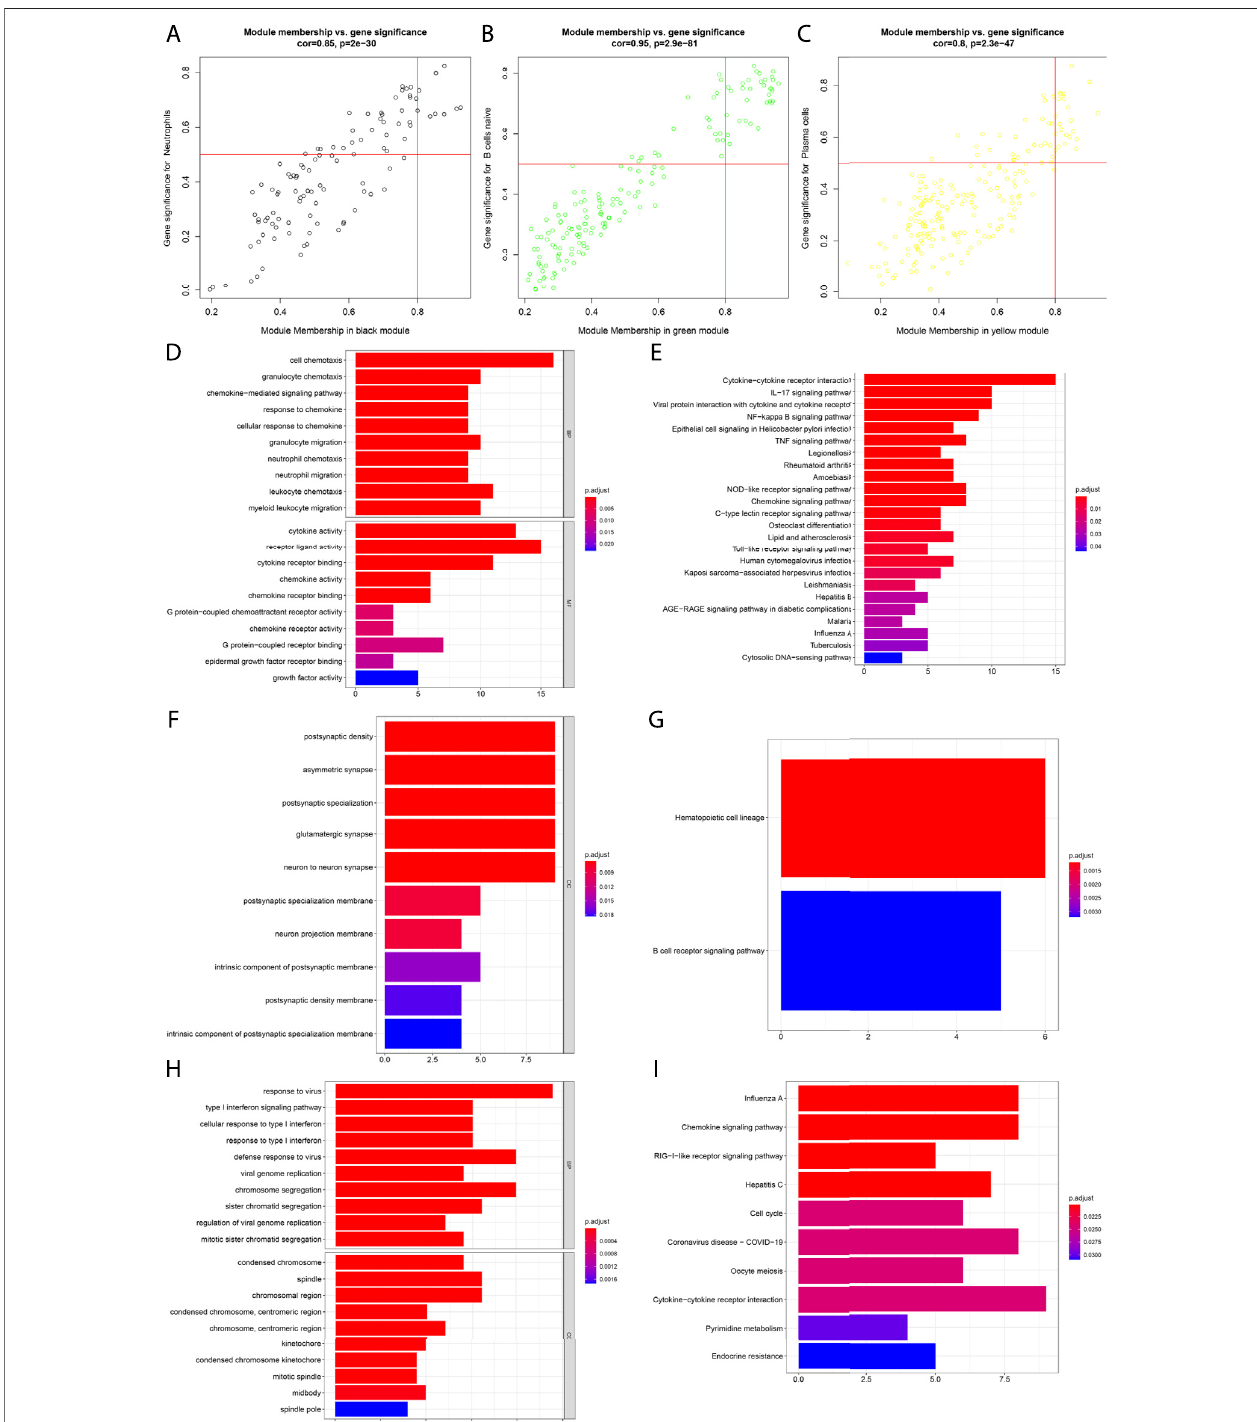
FIGURE2| Analysesofimmunecell-in fi ltration-relevantgenesandtheirbiologicalsigni fi cance. (A) Scatterplotsdepicttheinteractionsofmodulemembershipwith gene signi fi cance for neutrophils in the black module. (B) Scatter plots show the interactions of module membership with gene signi fi cance for B cells naïve in the green module. (C) Scatter plots present the interactions of module membership with gene signi fi cance for plasma cells in the yellow module. (D,E) GO and KEGG enrichment results ofgenesin the black module. (F,G) GO and KEGG enrichmentresults ofgenes in the green module. (H,I) GO and KEGG enrichment results of genes in the yellow